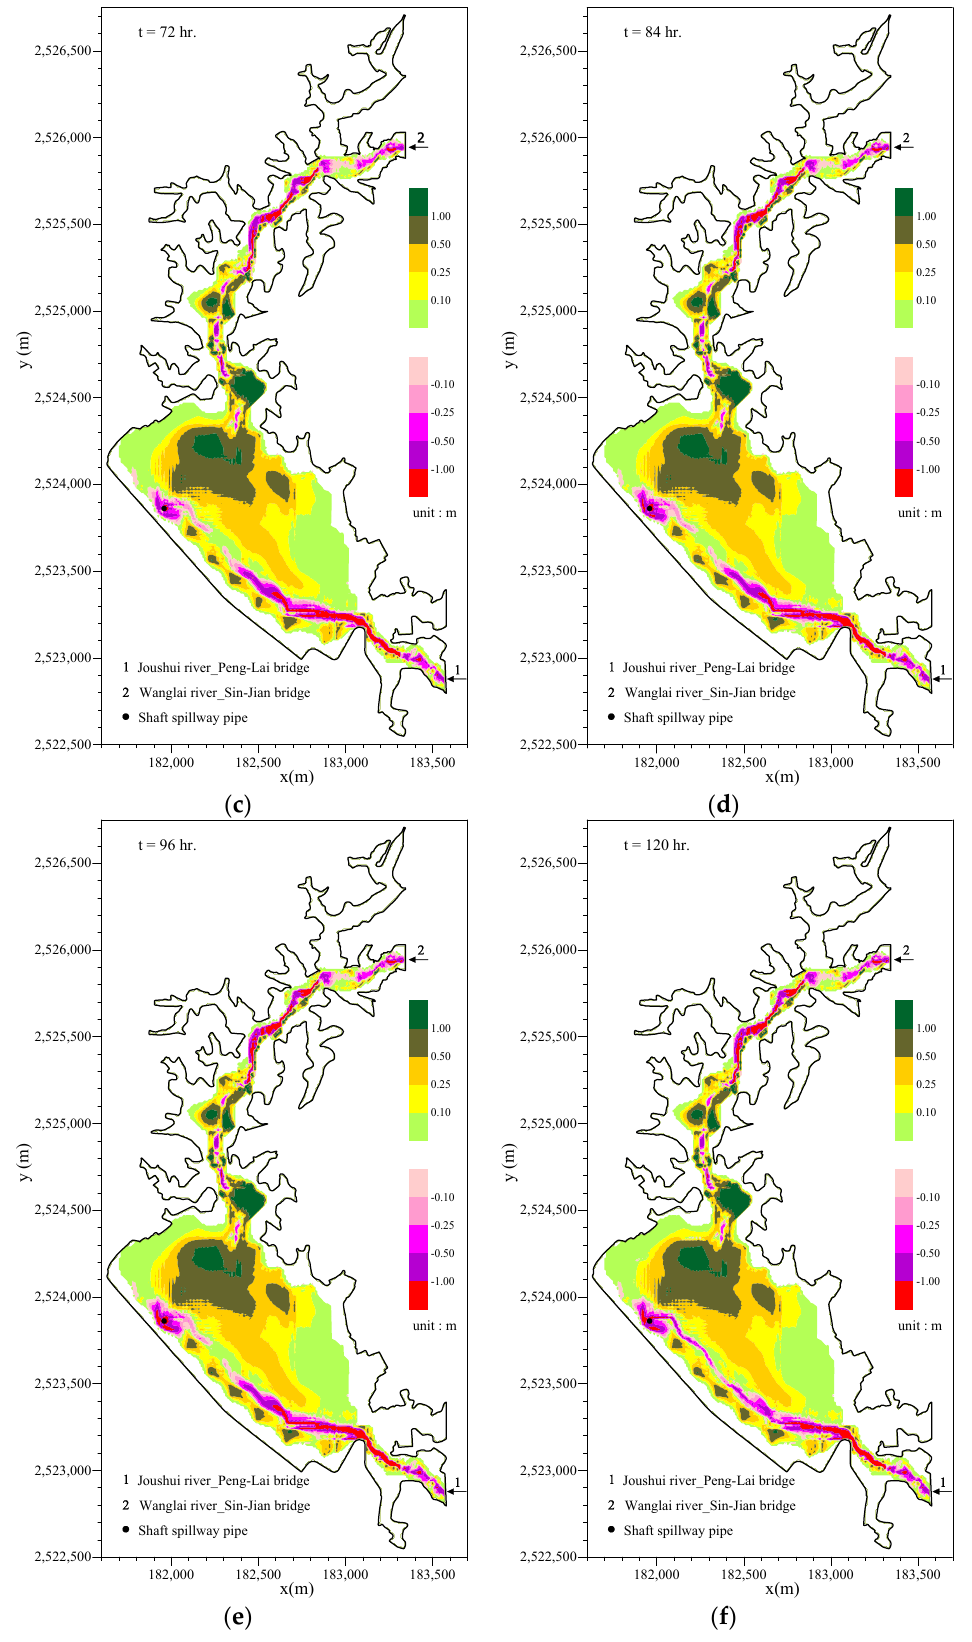
Figure 6. ( a ) Bed evolution in the reservoir at t = 36 h; ( b ) Bed evolution in the reservoir at t = 60 h; ( c ) Bed evolution in the reservoir at t = 72 h; ( d ) Bed evolution in the reservoir at t = 84 h; ( e ) Bed evolution in the reservoir at t = 96 h; and, ( f ) Bed evolution in the reservoir at t = 120 h.